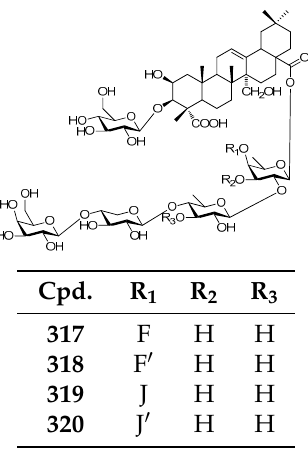
Figure 64. Structures of compounds 317 – 320 .